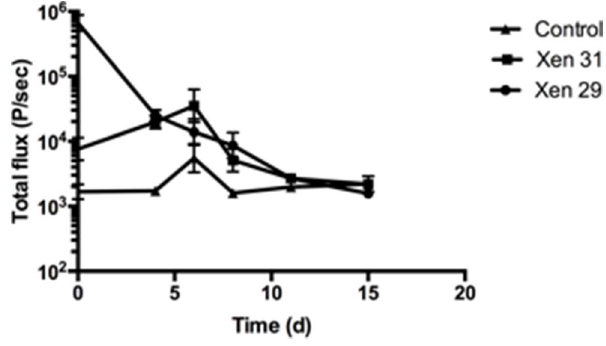
Figure 6. Bioluminescent imaging: mean Total flux (P/sec) 6 SD for X29, X31 and sterile implant. 2 minutes high sensitivity measurement of 1,5 cm 2 ROI. Xen 29 demonstrates a steady decrease in total photon flux, from 6.6 6 10 6 P/sec to 1.5 6 10 4 P/sec by day 15, which correspond to the levels seen in negative controls. Xen30 demonstrated an initial increase in bioluminescence from 7.5 6 10 4 to 3.5 6 10 5 P/sec from day 0 to 6, followed by a decrease to 5.1 6 10 4 P/sec on day 8 and by day 11 it’s signal was comparable to the negative control. While the BLI intensity demonstrated great change over time, bacterial load in the infected tibias (2 logs higher than the bacterial load from the implants and is thus the principal contributor to the BLI signal intensity) remains stabile during day 8–15, in which the BLI intensity from both strains reaches the same intensity as the negative controls.